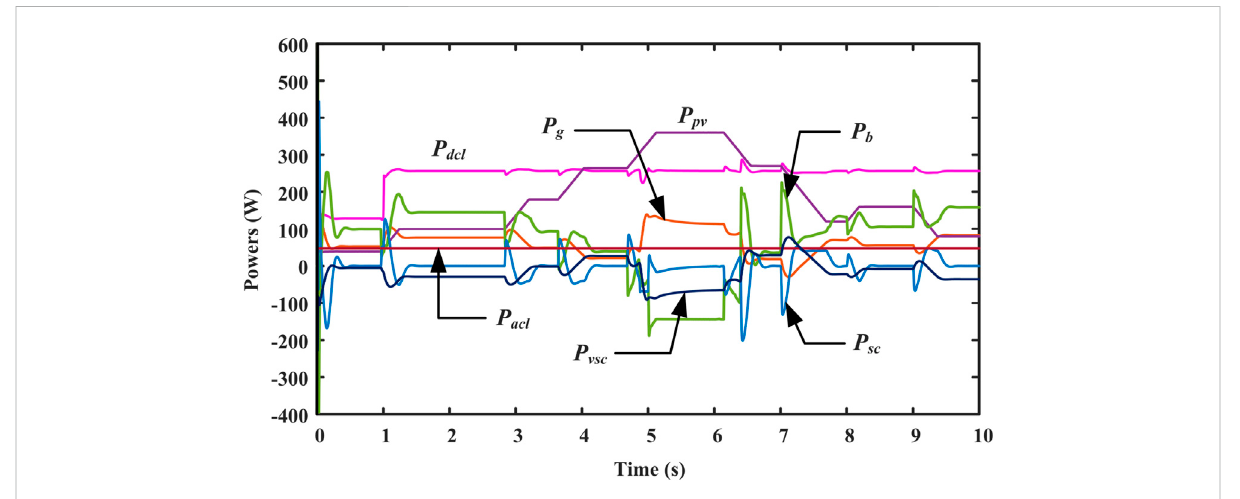
FIGURE 14 Various power